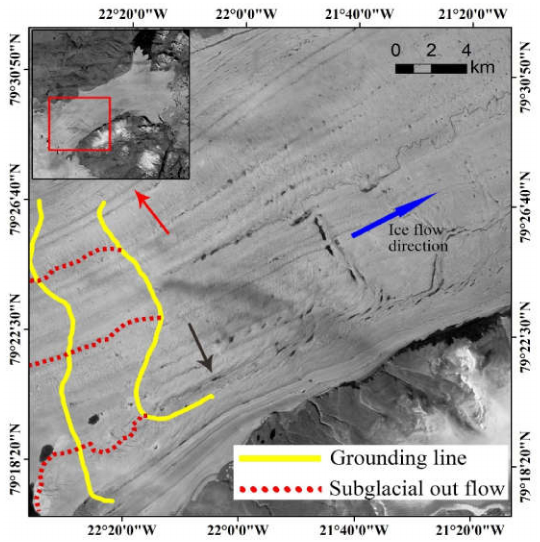
Figure 8. A portion of the 79NG ice shelf as shown in the 2012 Landsat imagery. The red arrow marks a grounding-line-sourced basal channel. Black arrow marks a subglacially-sourced